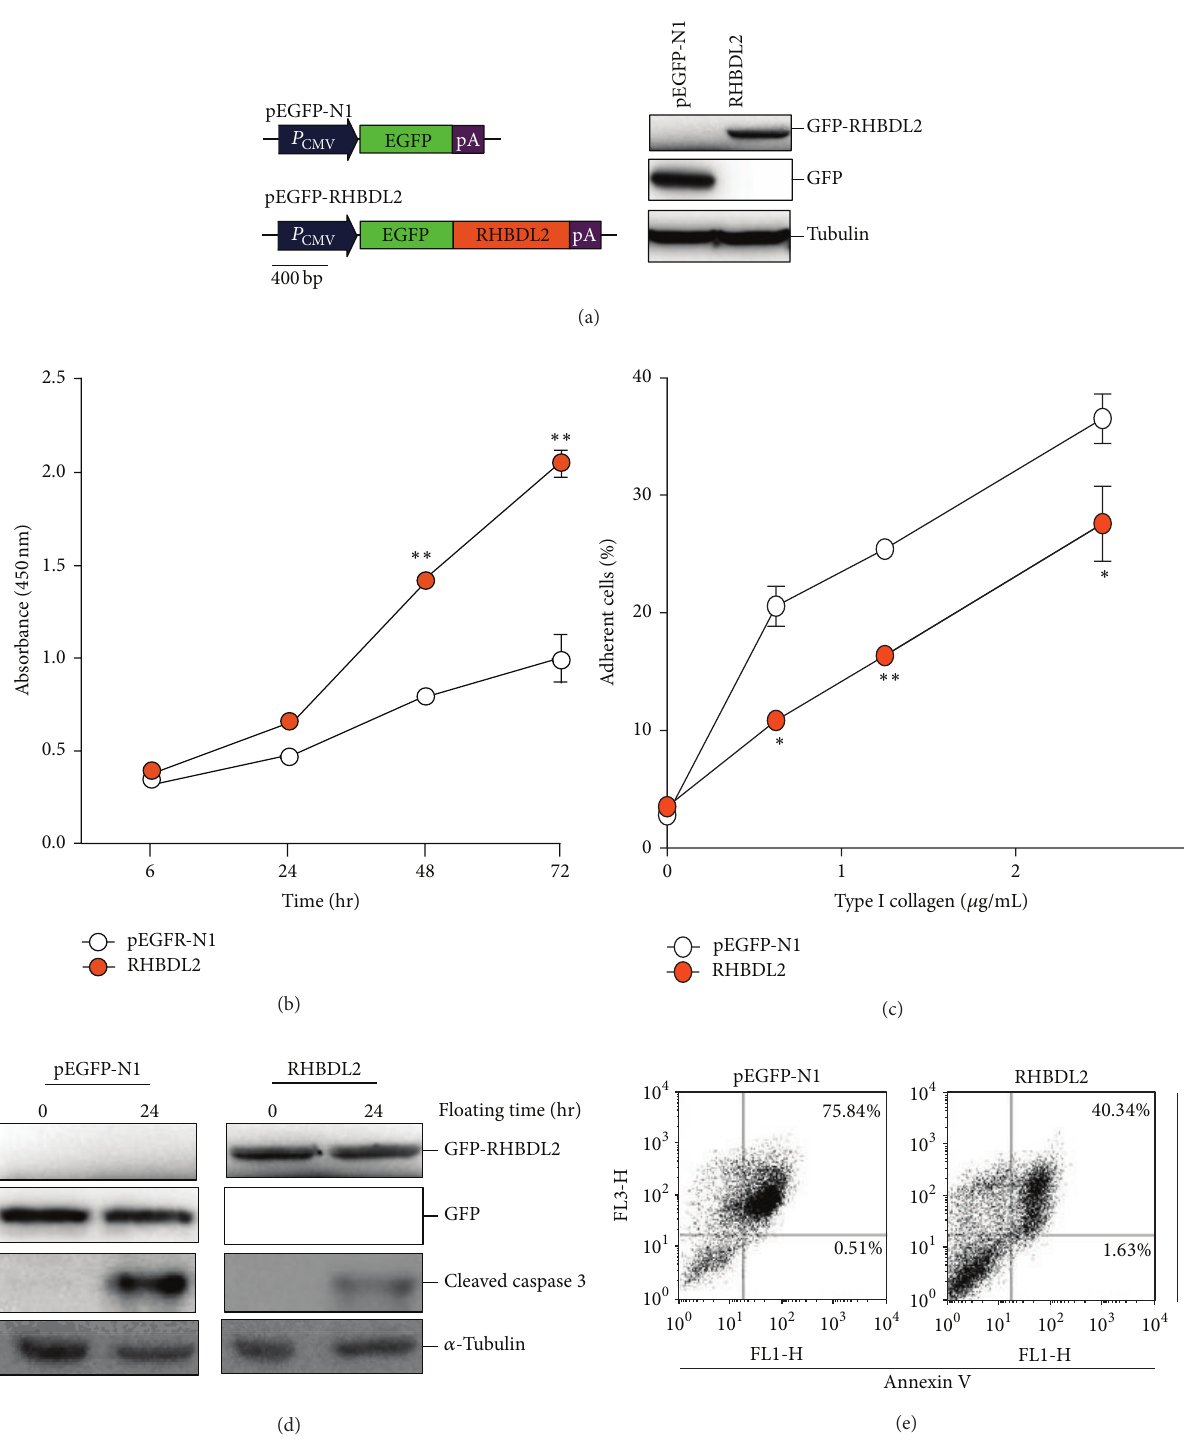
Figure 1: RHBDL2 overexpression leads to promotion of cell proliferation, reduction of adhesion ability, and suppression of homeless cell death in human keratinocytes. (a) The illustrated RHBDL2 expression construct and the control vector and relative protein expression levels in stable transfected HaCaT cells. (b) Proliferation of the two stable transfected HaCaT cells was measured using the WST-1 assay. (c) Adhesive ability of the different transfected cells was quantified by type I collagen adhesion assay. (d) Activation of caspase 3 under floating culture condition in stable transfected cells was investigated by Western blotting. (e) Quantification of apoptotic cells in stable cells floating for 24 hours by using Annexin V-FITC/PI staining. ∗ 𝑃 < 0.05 ; ∗∗ 𝑃 < 0.01